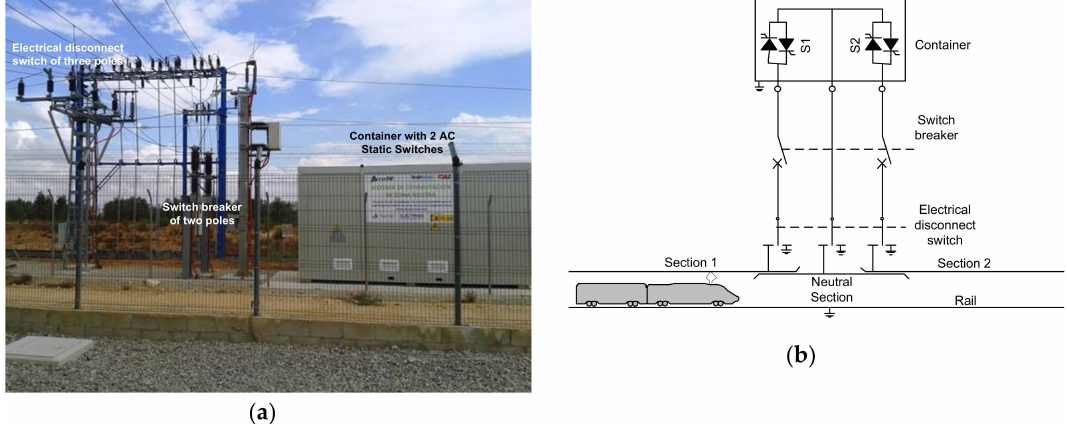
Figure 9. ( a ) Container with two AC static switches and connection to the HSR; ( b ) electrical scheme with protections and connection to